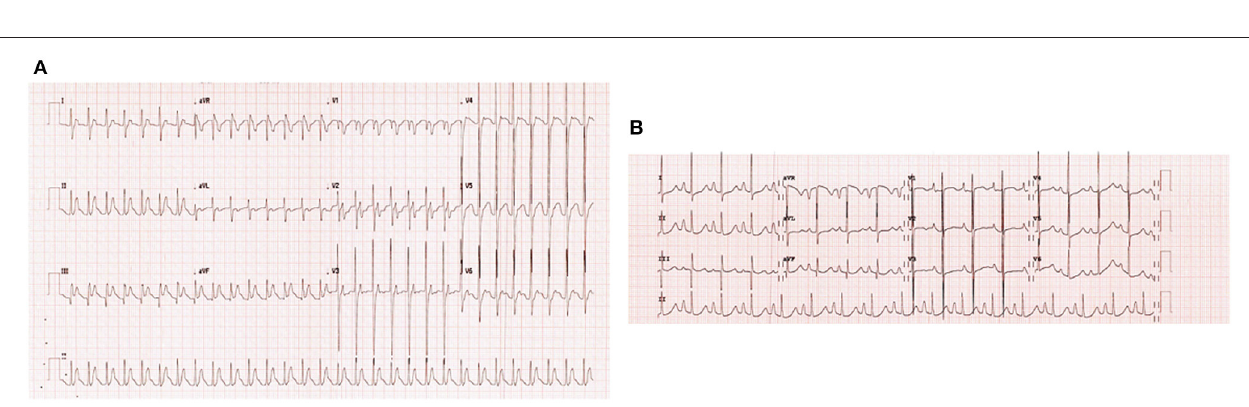
FIGURE 3 | ECGs of patient #1 pre- and post-ivabradine. (A) ECG revealing atrial tachycardia. (B) ECG revealing sinus rhythm (ECG speed: 25 mm/s, and sensitivity: 10 mm/mv). As discussed, this patient was successfully treated with ivabradine, she reverted from atrial tachycardia to sinus rhythm after receiving an adequate course of